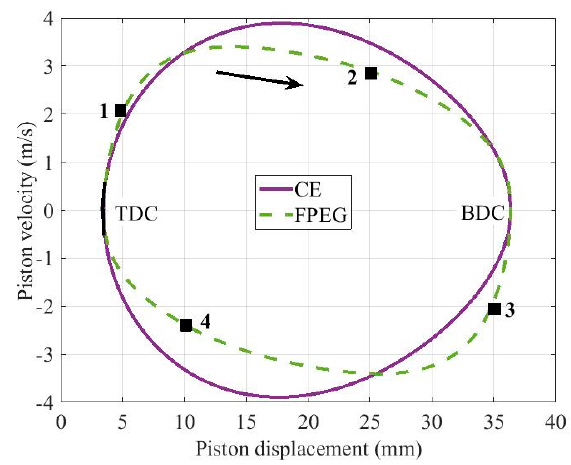
Figure 4. Comparison of FPEG and CE piston velocity.